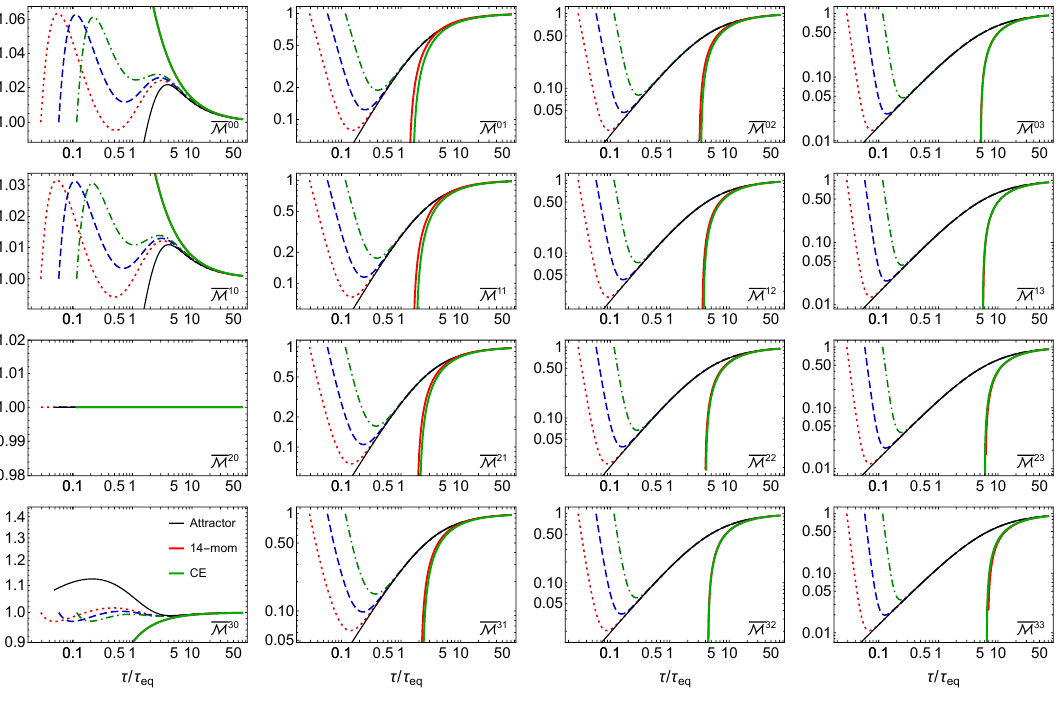
Figure 7 . Scaled moments M nl as a function of rescaled time for the case m = 5 GeV. Initial conditions and line styles are the same as in figure 3.